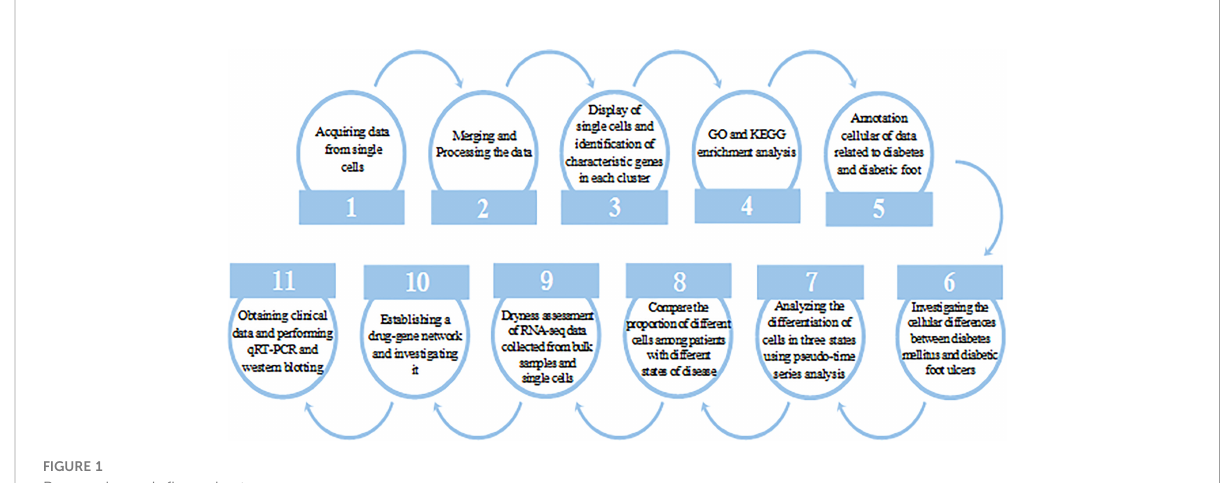
FIGURE 1 Research work fl ow chart.